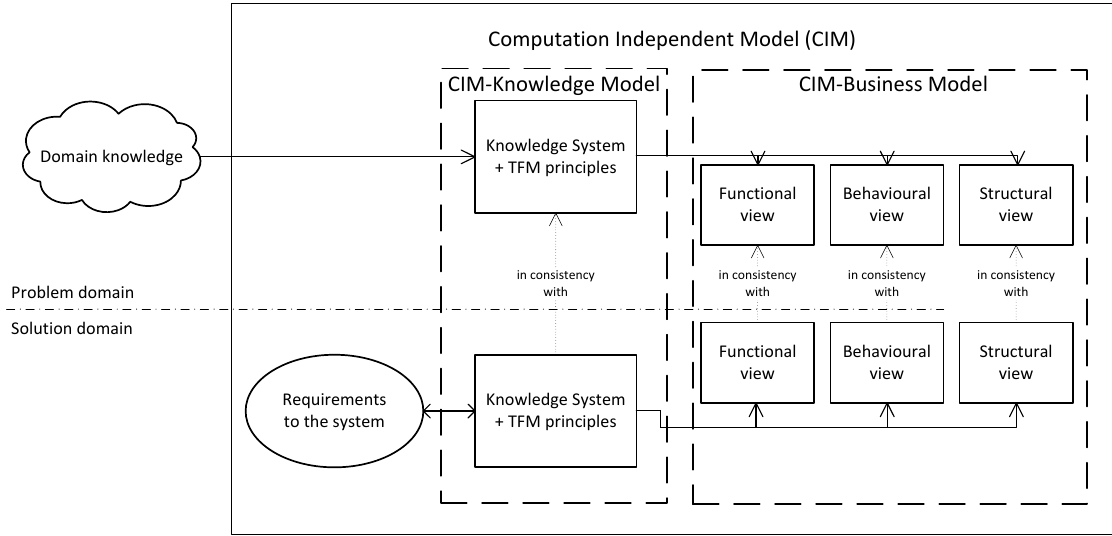
Fig. 1. The view on knowledge base at the computation independent